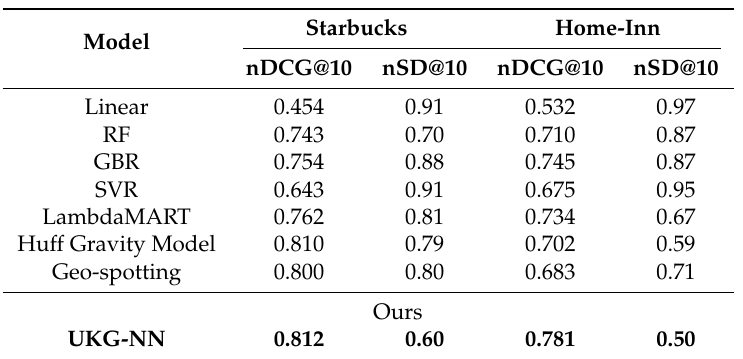
Table 2. Results for Starbucks and Home-Inn.